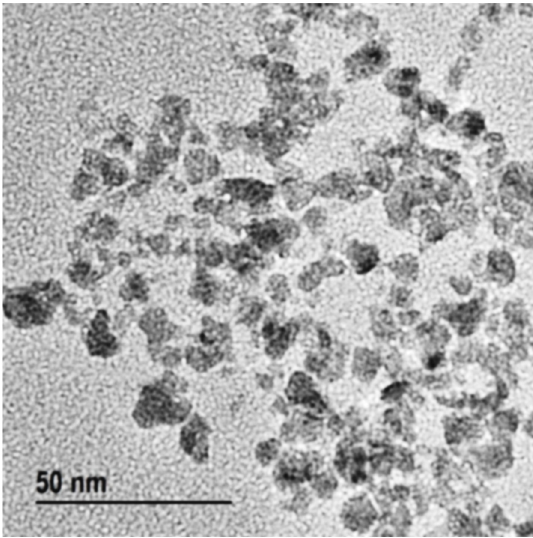
Figure 1. TEM image of CuSNP.